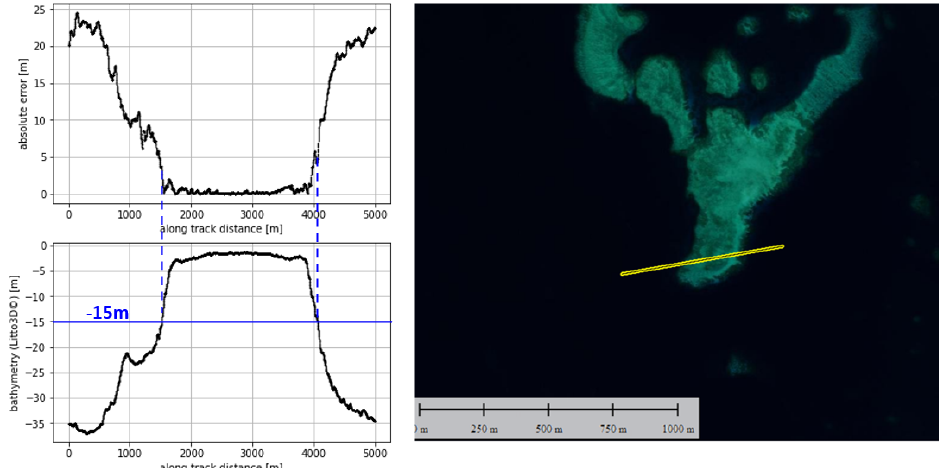
Figure A3. Evolution of the absolute error with depth on a transect across the ICESat-2 ground track.